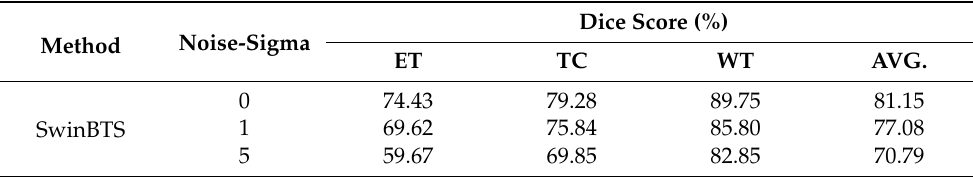
Table 7. Experiments of different degrees of